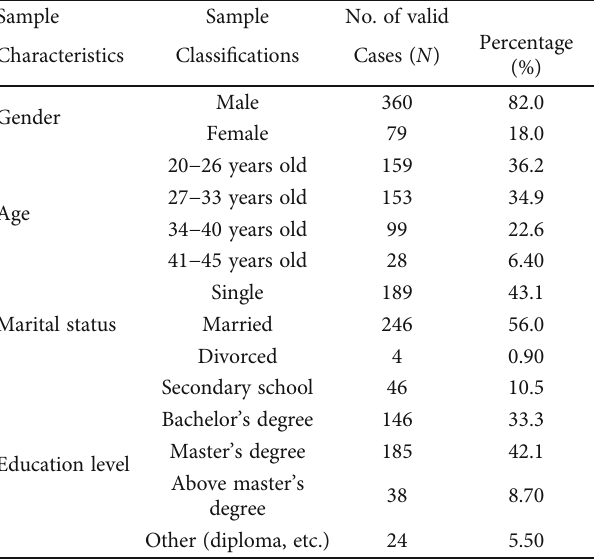
Table 3: Demographic distribution of sample ( N = 439